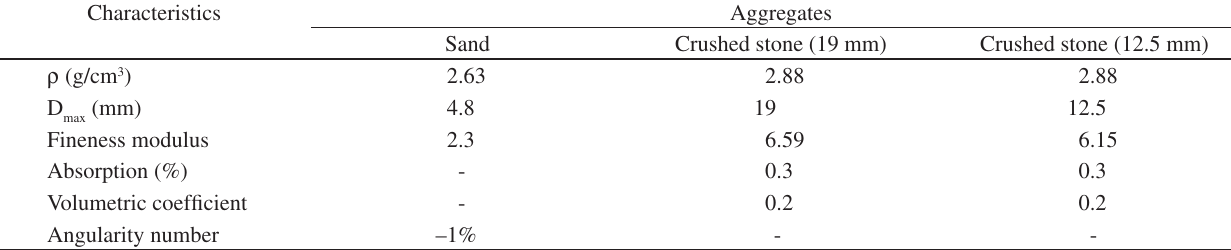
Table 2. Description of coarse and small aggregates.